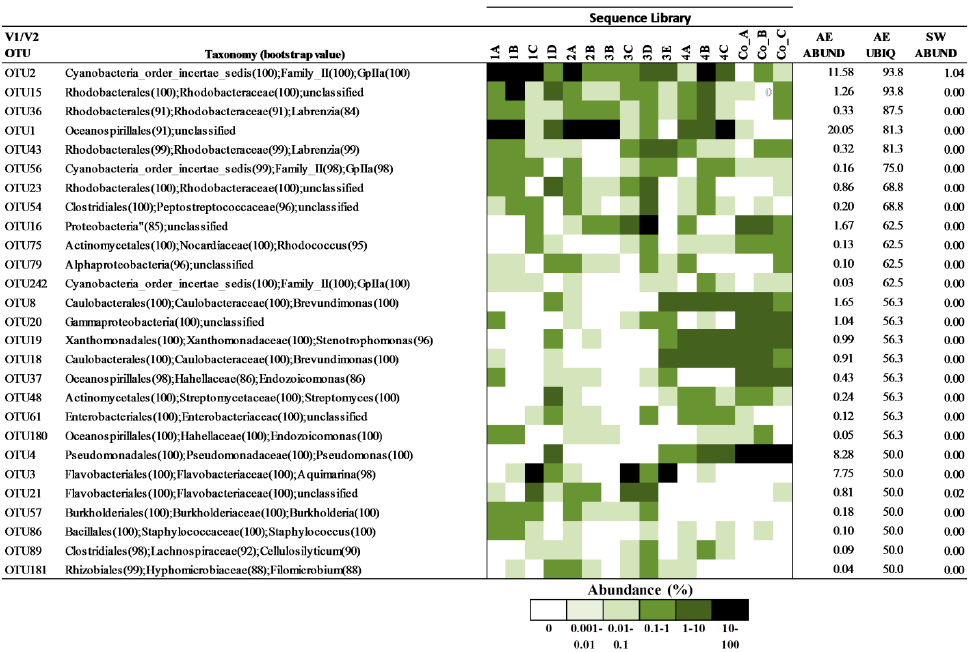
Figure 3. Heat map showing the distribution of OTUs in the V1/V2 dataset comprising the